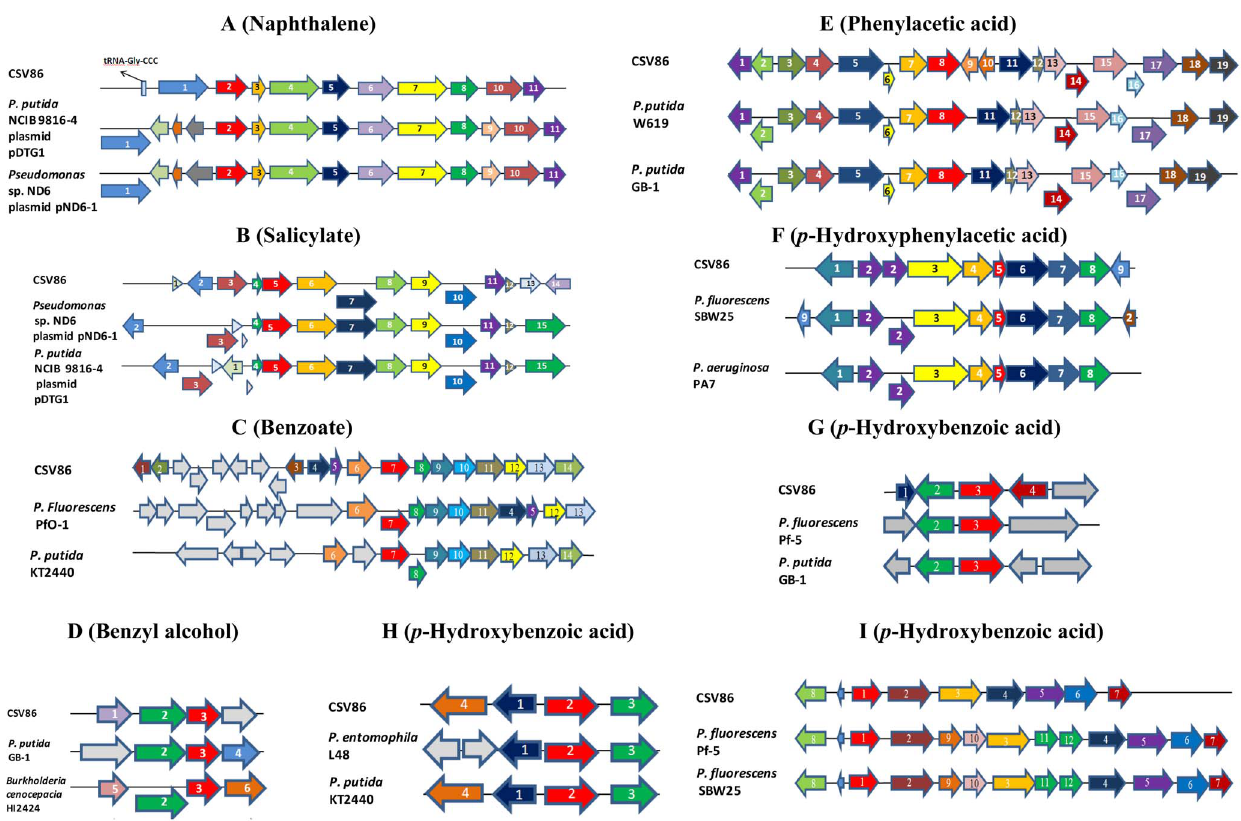
Figure 4. Gene organization of aromatic degradation pathways reported to be functionally characterized from Pseudomonasputida CSV86. A . Naphthalene pathway (Contig 105), B . Salicylate pathway (Contig 69), C . Benzoate pathway (Contig 175), D . Aromatic alcohol degradation pathway (Contig 119), E . Phenylacetic acid pathway (Contig 88), F , Hydroxylphenylacetic acid pathway(Contig 7) and G–I , 4-Hydroxybenzoate (Contig 107, 99, 118). For details refer to Figures S2, S3, S6, S7, S8, S9,